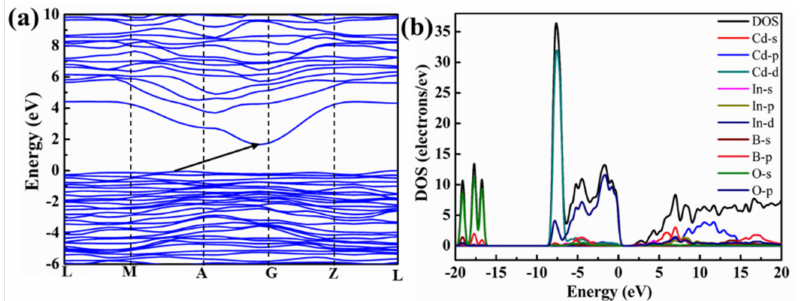
Figure 5. Electronic properties of CIBO: ( a ) Band structure; ( b ) total and partial DOS (density of